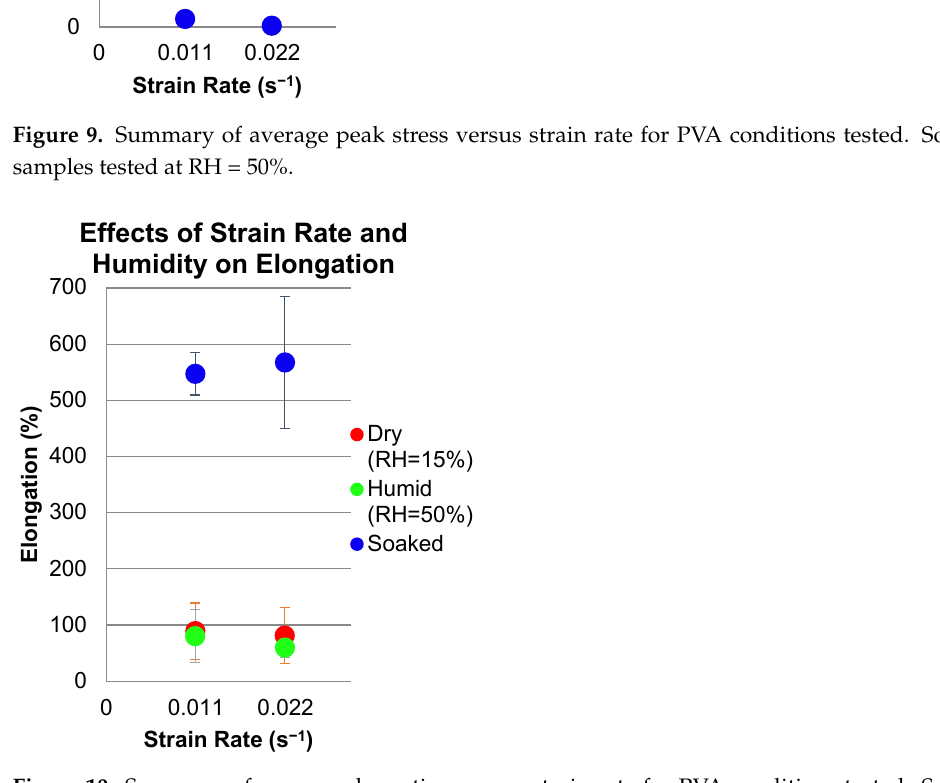
Figure 10. Summary of average elongation versus strain rate for PVA conditions tested. Soaked samples tested at RH = 50%.